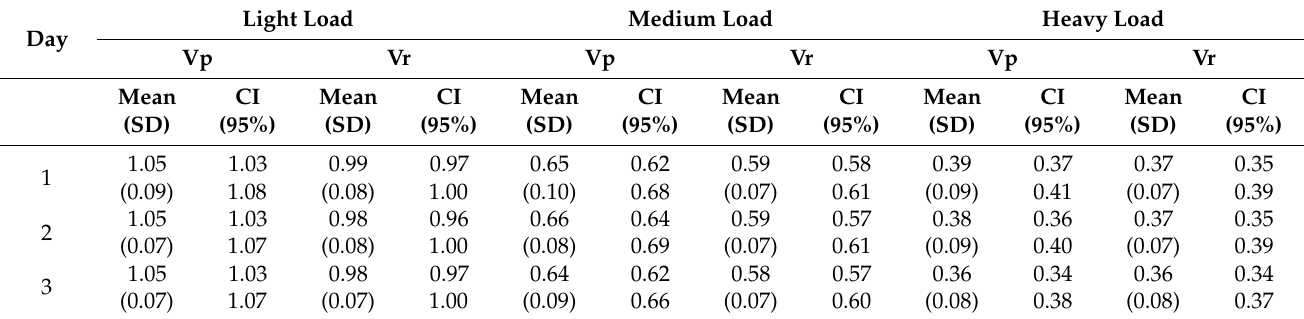
Table 3. Perceived velocity (Vp) and real velocity (Vr), in m · s − 1 , for the three intensities considered in the three testing sessions.